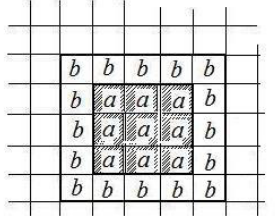
Figure 7. The output of pre-filtering of image in Fig. 2